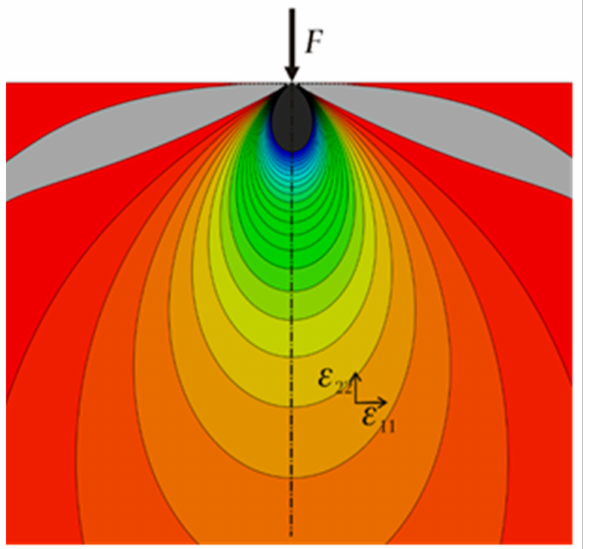
Figure 6. Strain ε 22 in the direction of the force—Flamant model without imperfections. A fragment of the model of the portal frame of an excavator undercarriage including the zone where strain gauges are to be located is shown in Figure 7. Various thicknesses of the sheets are marked with different colors.